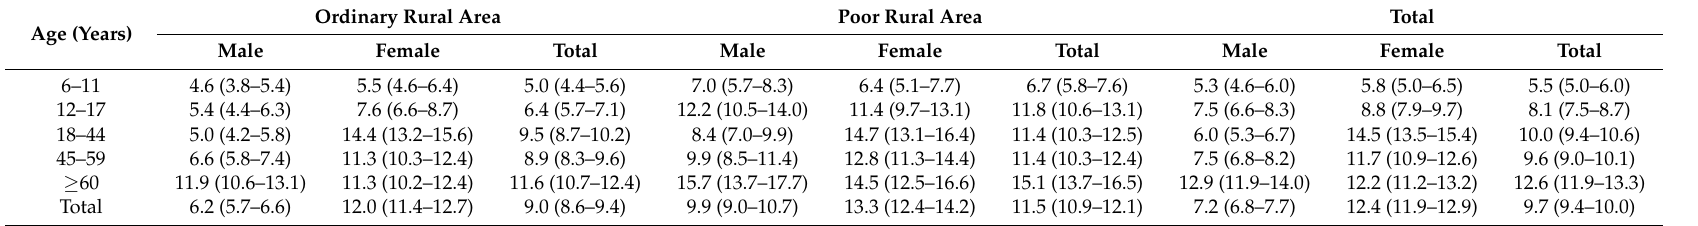
Table 5. 2010–2012 China’s rural residents’ anemia prevalence (% 95% CI (Confidence interval)).